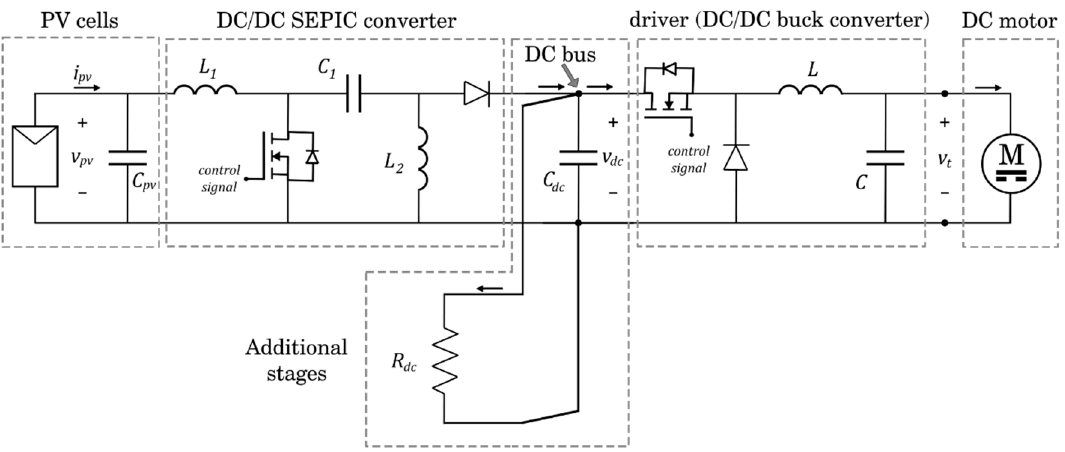
Figure 1. Proposed system to regulate the angular speed of a DC motor powered by PV cells.